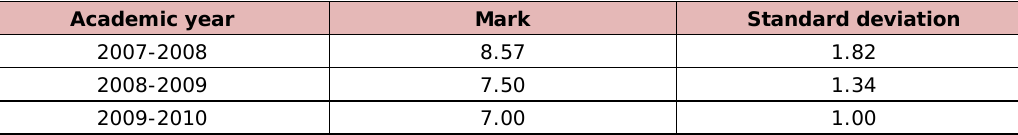
Table 4. “Results of the opinion poll about the usefulness of the concept maps in the subject Analytical Techniques of the